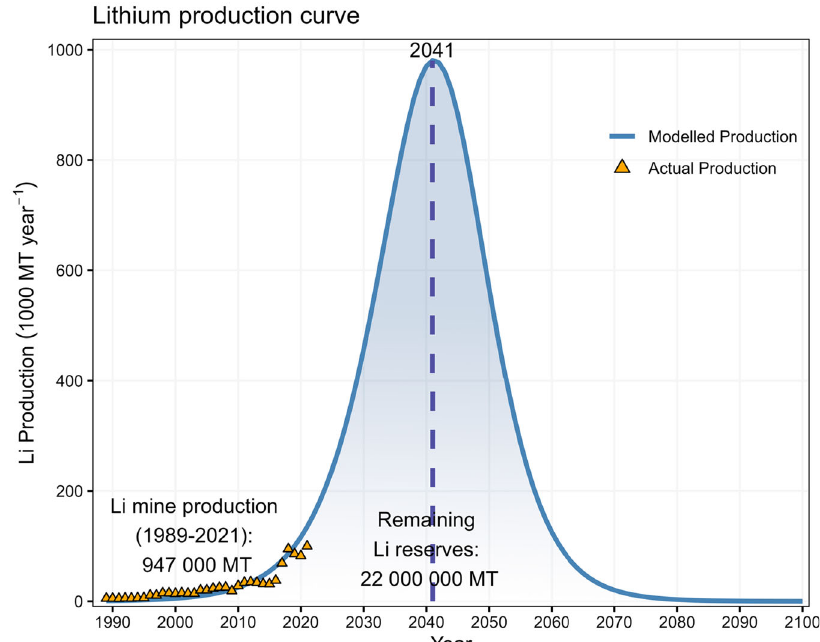
Fig. 2 Peak Li production curve based on world mine production data and USGS reports indicates a maximum production in year 2041. The data presented in the fi gure were obtained from reports published between 1989 and 2020, and the Gaussian distribution curve was fi tted to the data with a least-squares